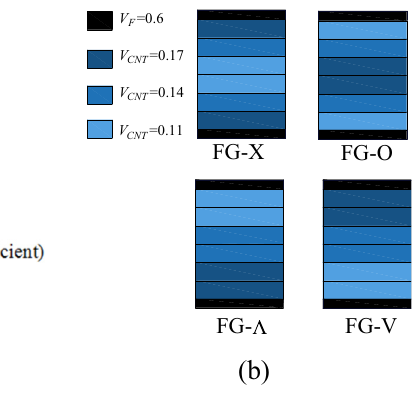
Figure 3: Coordinate system and various con fi gurations of hybrid laminated